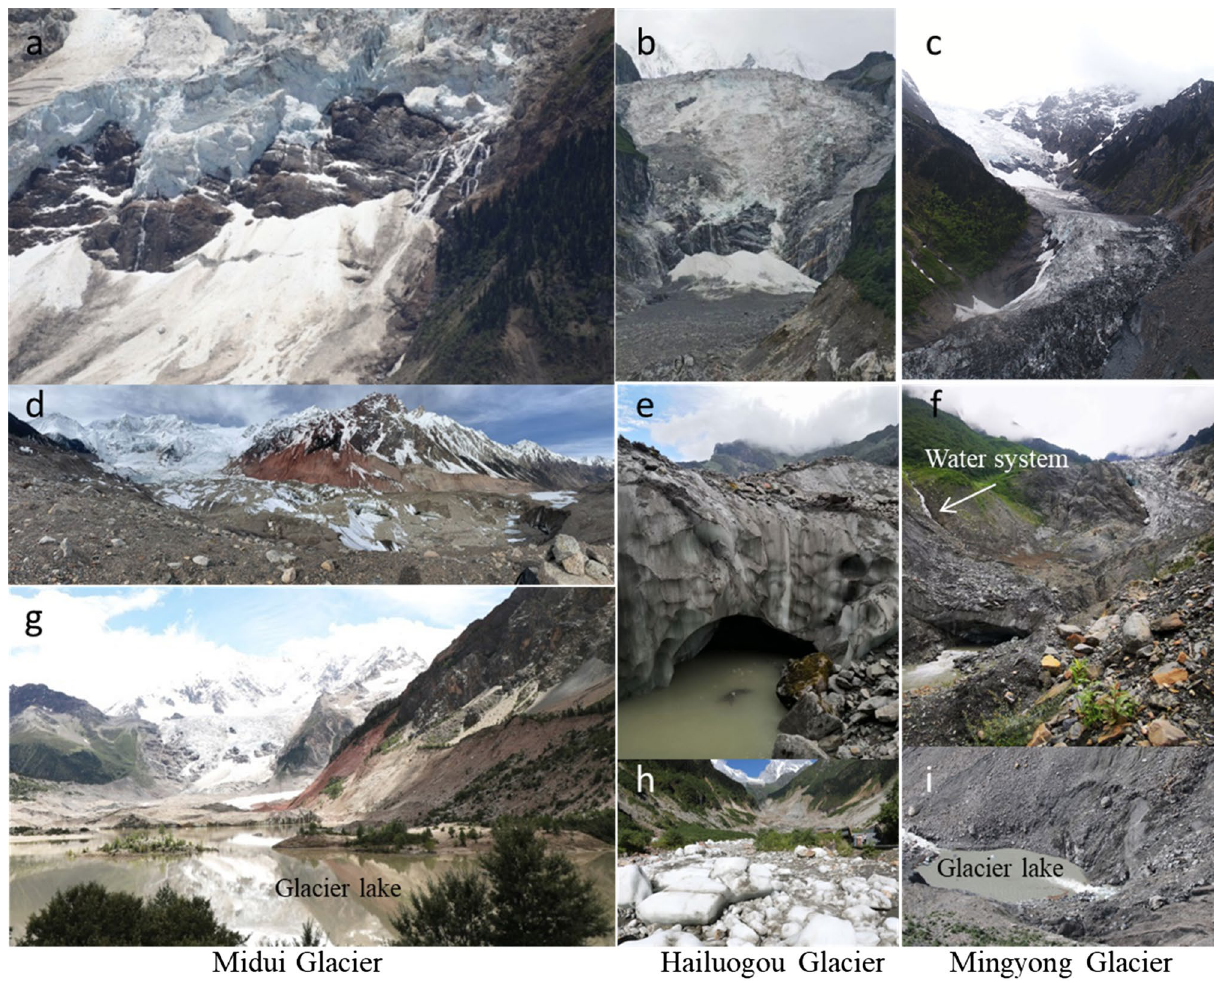
Figure 6. Some new features of rapid changes in temperate glaciers. ( a , b , c ) the separation of glacier accumulation area and melting area: ( d ) is a collapsed landform of the ice surface caused by the outburst of water systems within the ice body; ( e , f ) is two outlets at glacier terminal; ( g , i ) is two moraine lakes of glacier terminal; ( h ) shows a large amount of remaining ice blocks formed by the outburst of water system within the ice